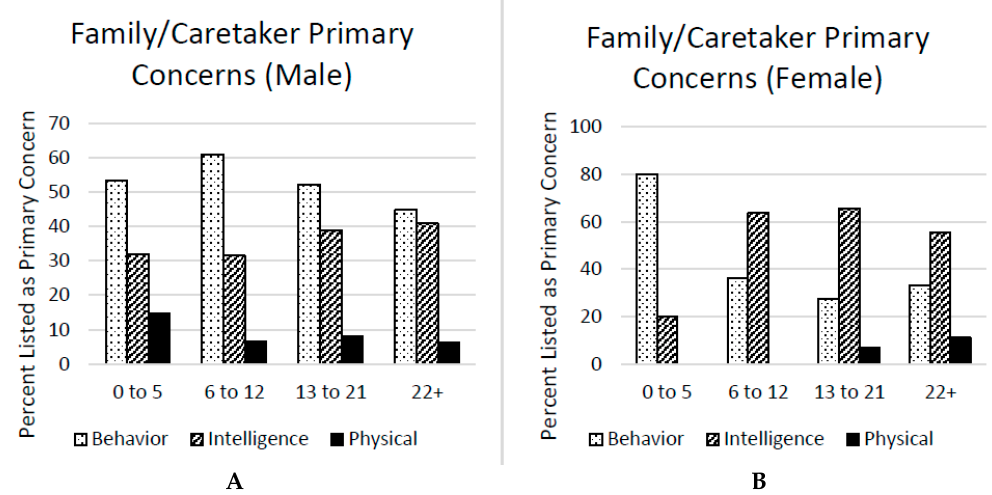
Figure 2. Primary concerns of family members/caretakers of males ( A ) and females ( B ) with FXS.